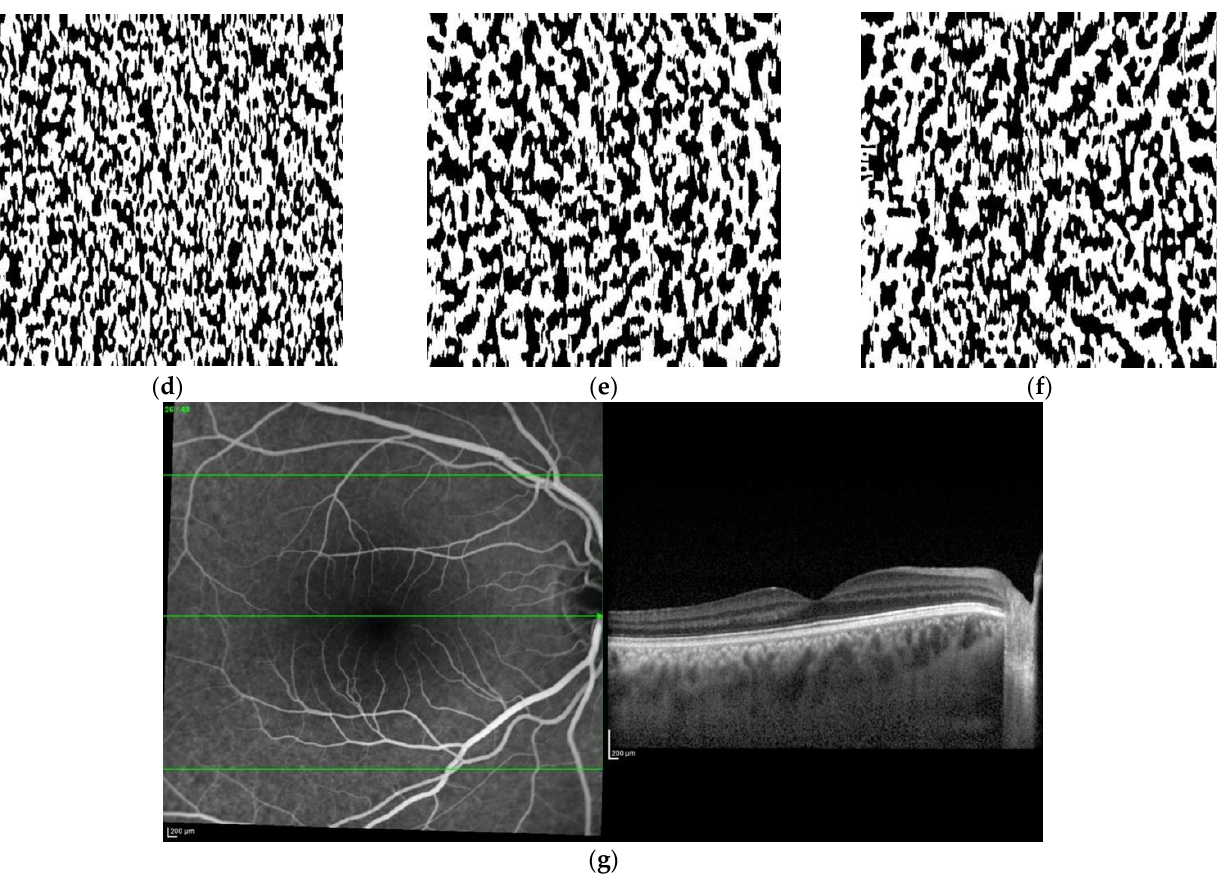
Figure 2. Original en face optical coherence tomography (OCT) scans and the software-processed images of the fellow eye of the same patient of Figure 1. Original en face OCT scan images of the superficial ( a ), medium ( b ) and deep ( c ) choroidal layer; binarized images of the superficial ( d ), medium ( e ) and deep ( f ) choroidal layer; OCT B-scan across the foveal center ( g ).